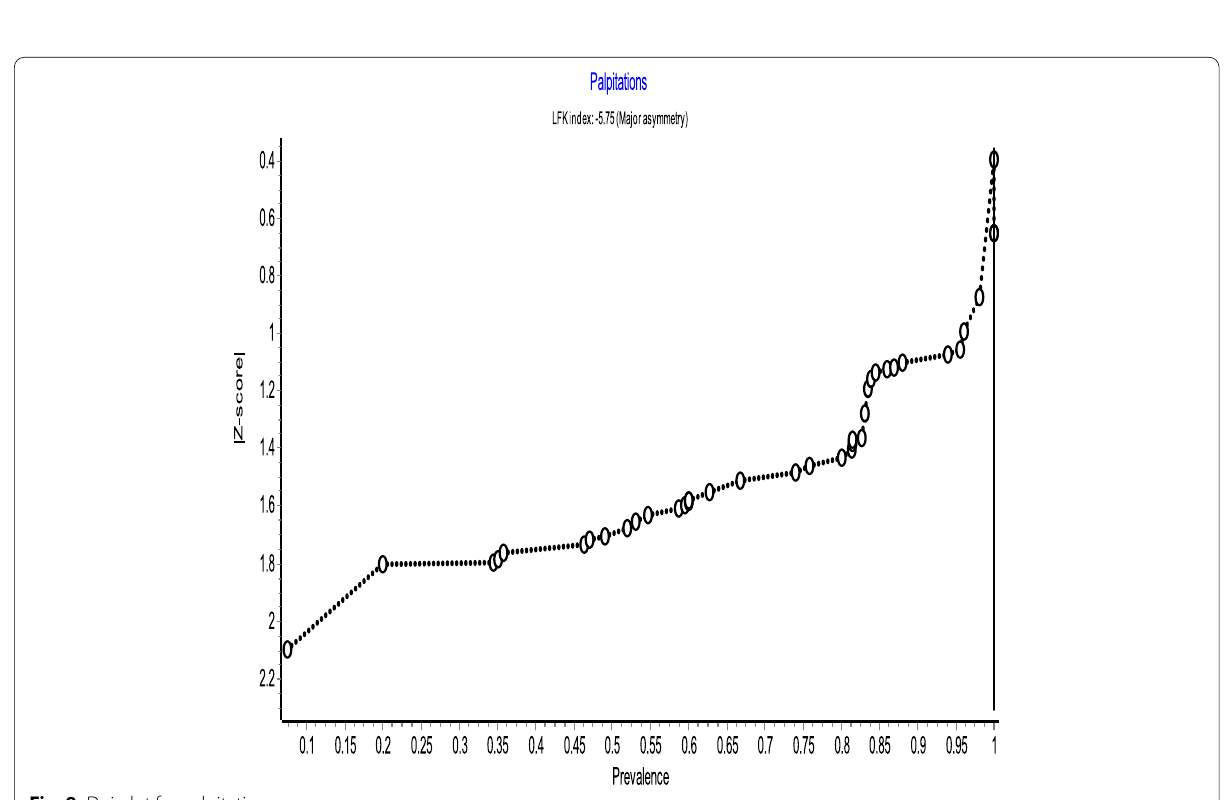
Fig. 9 Doi plot for